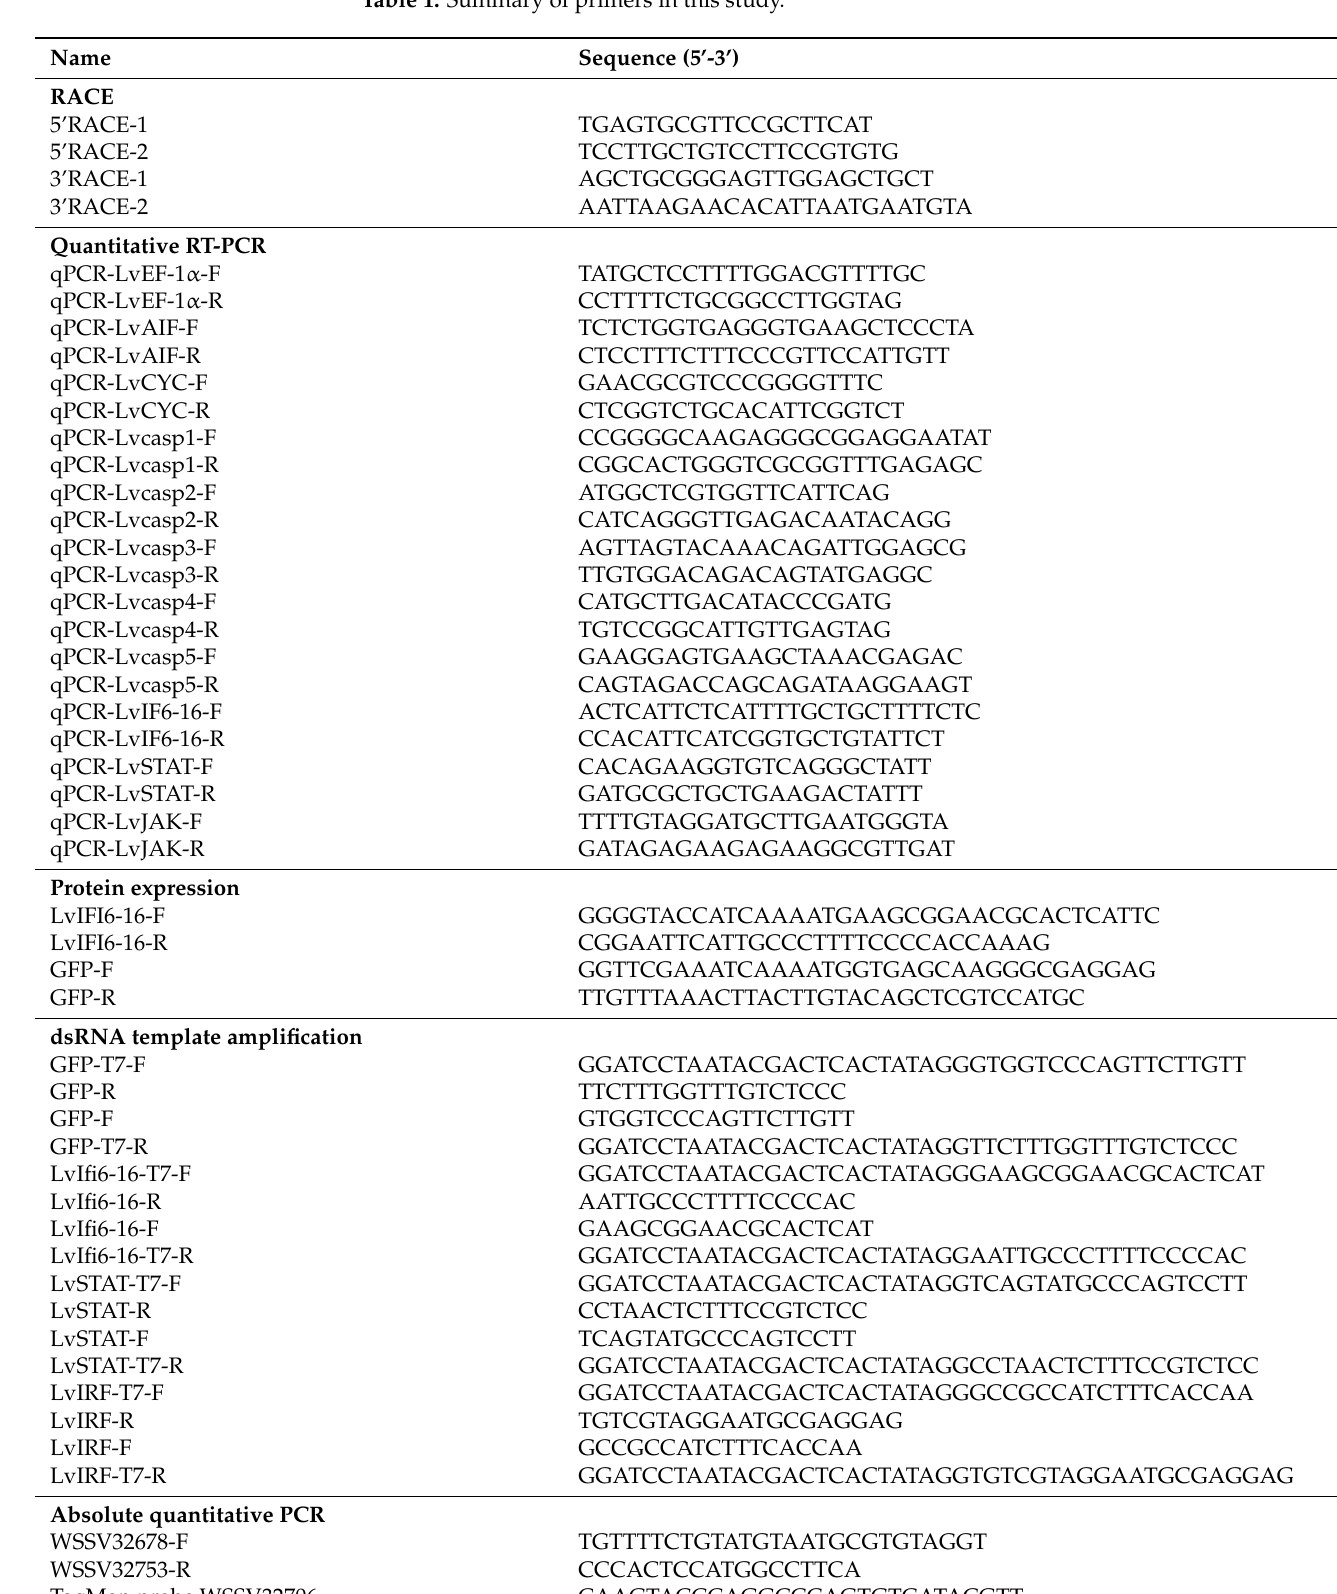
Table 1. Summary of primers in this